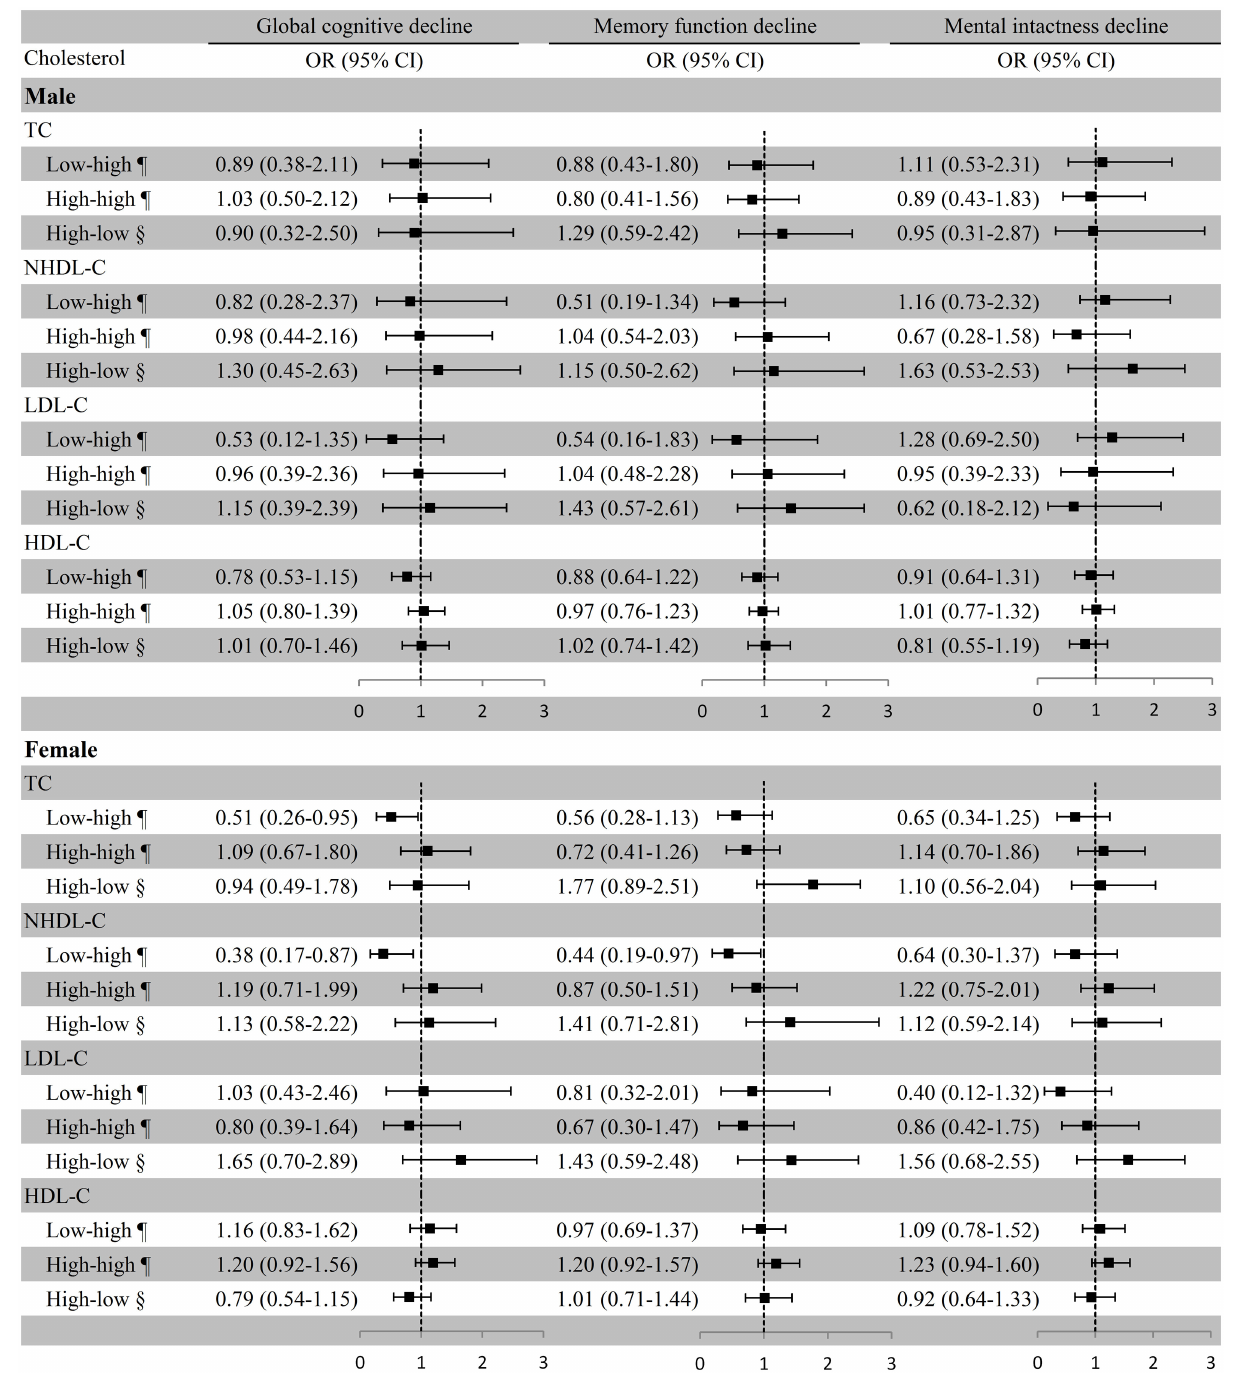
Frontiers in Aging Neuroscience |